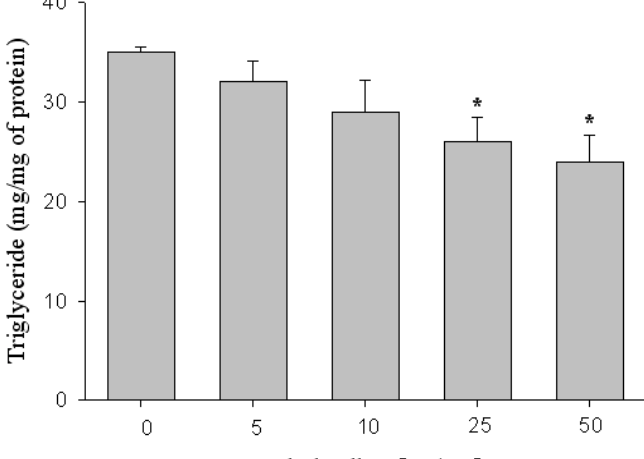
Figure 5. Effects of methyl gallate on adipocyte differentiation in 3T3-L1 cells. Cells were cultured in the medium containing methyl gallate, and lipid accumulation was measured by triglyceride (TG) content. X: concentration Y: Triglyceride (mg/mg protein). Values are expressed as mean ± standard deviation of at least three independent from that of the control treatment. * p <